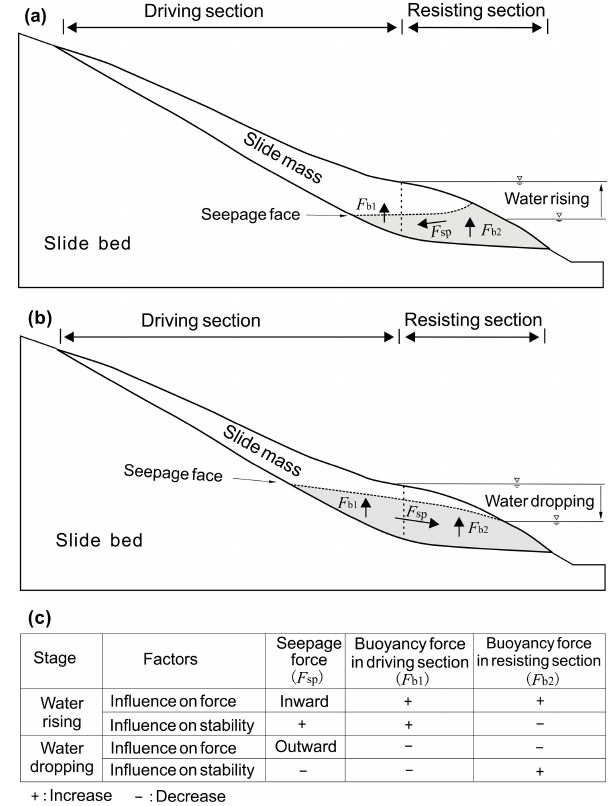
Figure 6. Mechanical mechanism for reservoir-induced landslide. (a) Water level rise, (b) water level drop, (c) effects of various mech- anisms on the landslide stability during water level rise and